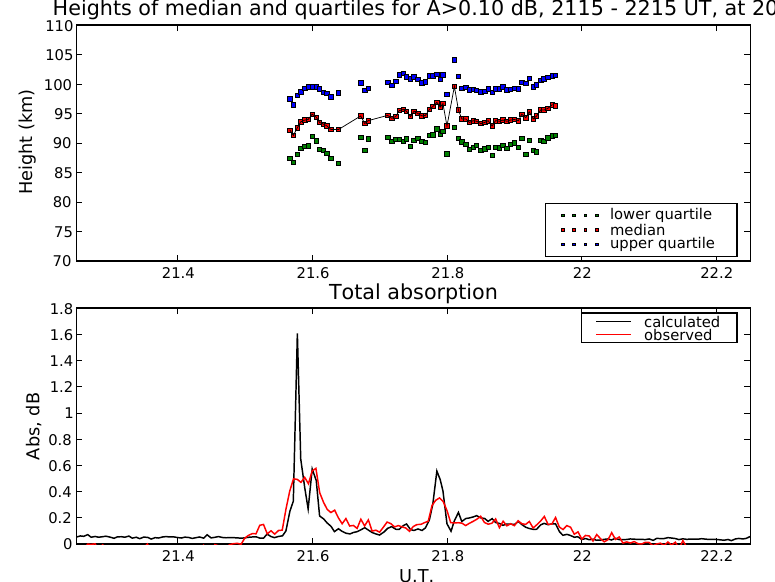
Fig. 7. Above: Heights of medians and quartiles for the absorbing region during the evening event of 1 July. Below: Total 38.2MHz, calculated and